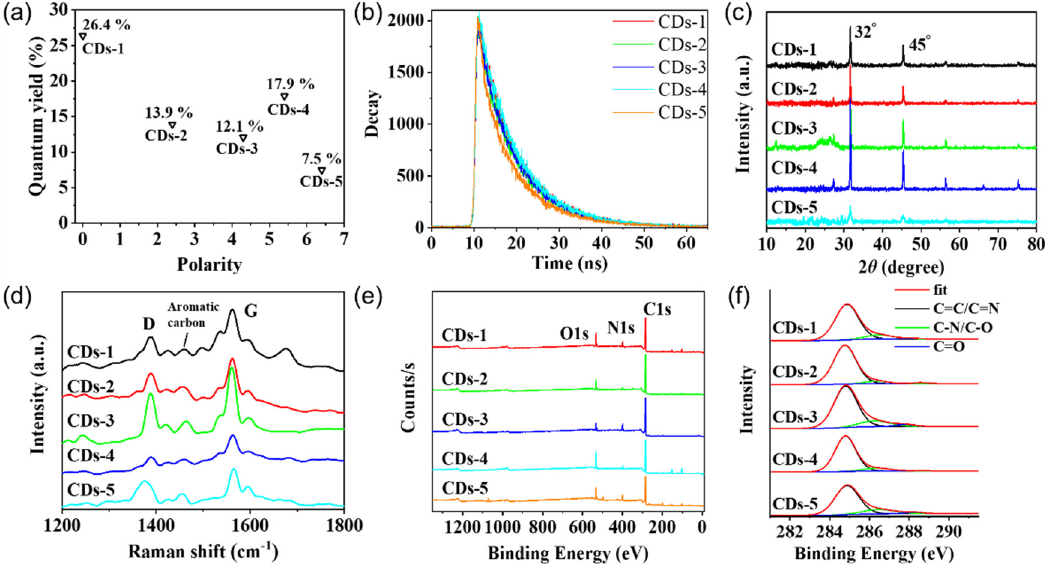
Figure 3. ( a ) Scatter diagram of the carbon dot quantum yields vs. the polarity of the reaction solvent. ( b ) Photoluminescent decays of CDs-1 to CDs-5 (0.1 mg/mL) in ethanol. XRD patterns. ( c ) Raman spectra. ( d ) XPS survey spectra. ( e ) High- resolution C1s spectra ( f ) of CDs-1 to CDs-5.